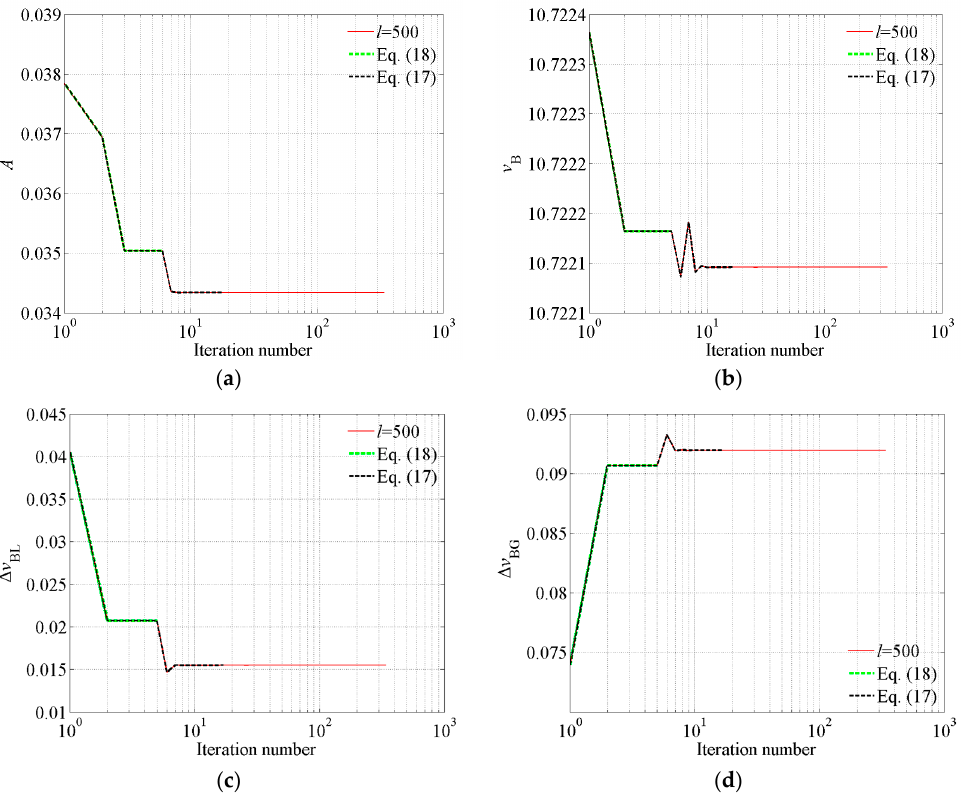
Figure 1. Change of the extracted key parameters corresponding to different convergence criterions with the iteration number. ( a ) A , ( b ) v B , ( c ) Δ v BL , ( d ) Δ v BG .